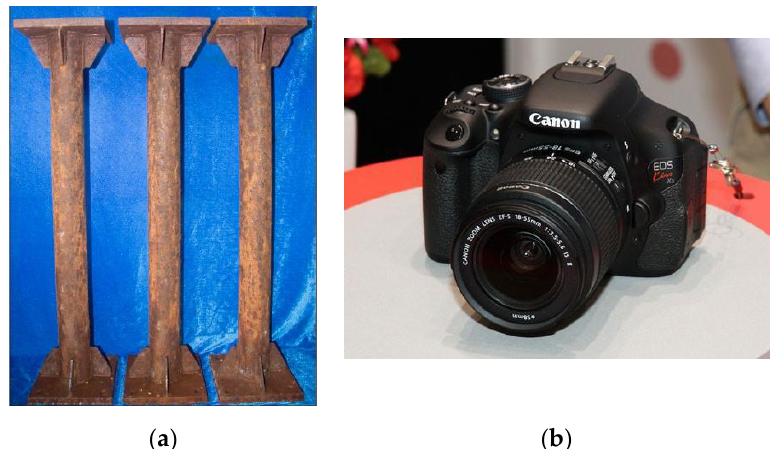
Figure 1. Image acquisition equipment and schematic representation of members: ( a ) Schematic representation of CCSTs, ( b ) Canon EOS600D.